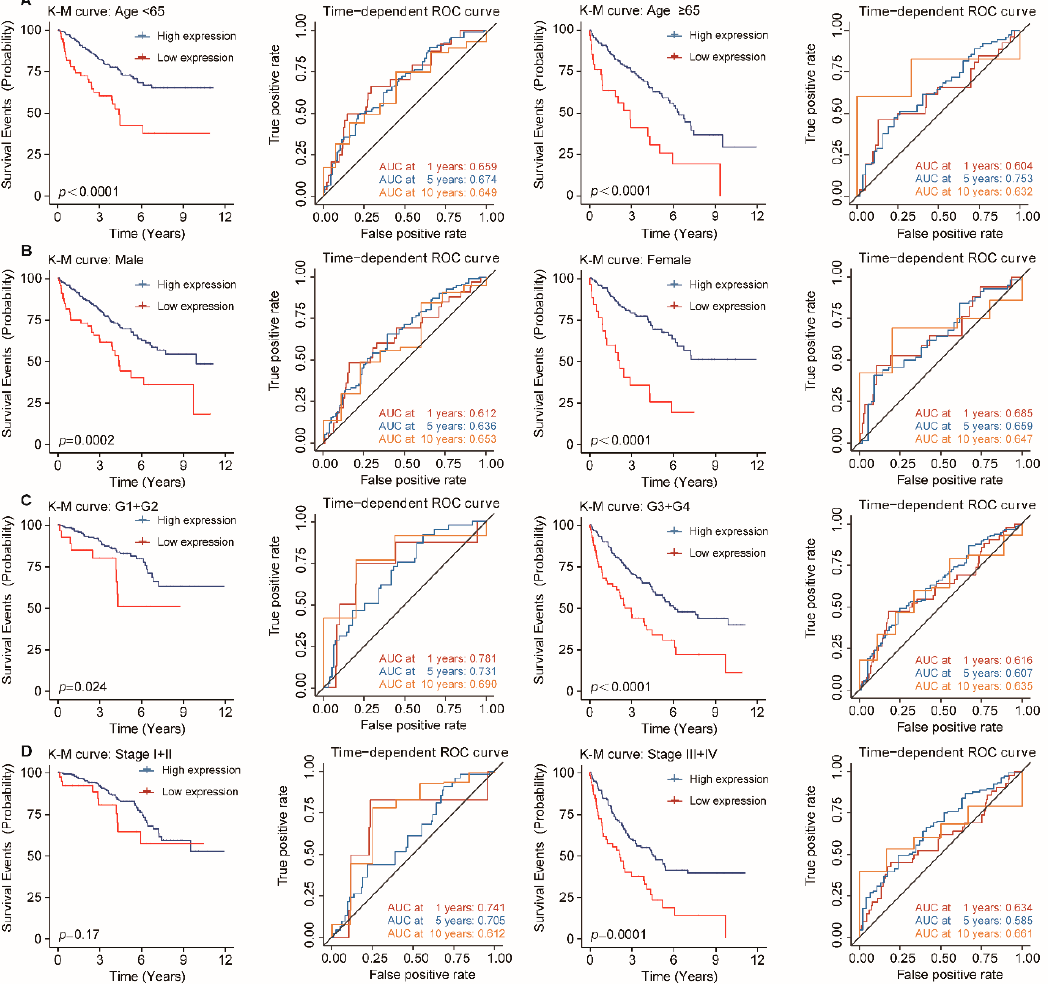
Figure 5. Stratification analysis of OS for FDX1 in ccRCC patients. Kaplan–Meier and time-dependent ROC curves illustrate the prognostic value of FDX1 based on the stratification of different clinical char- acteristics. Notes: ( A ) Age; ( B ) Gender; ( C ) Histological tumor grade; ( D ) Pathological tumor stage.